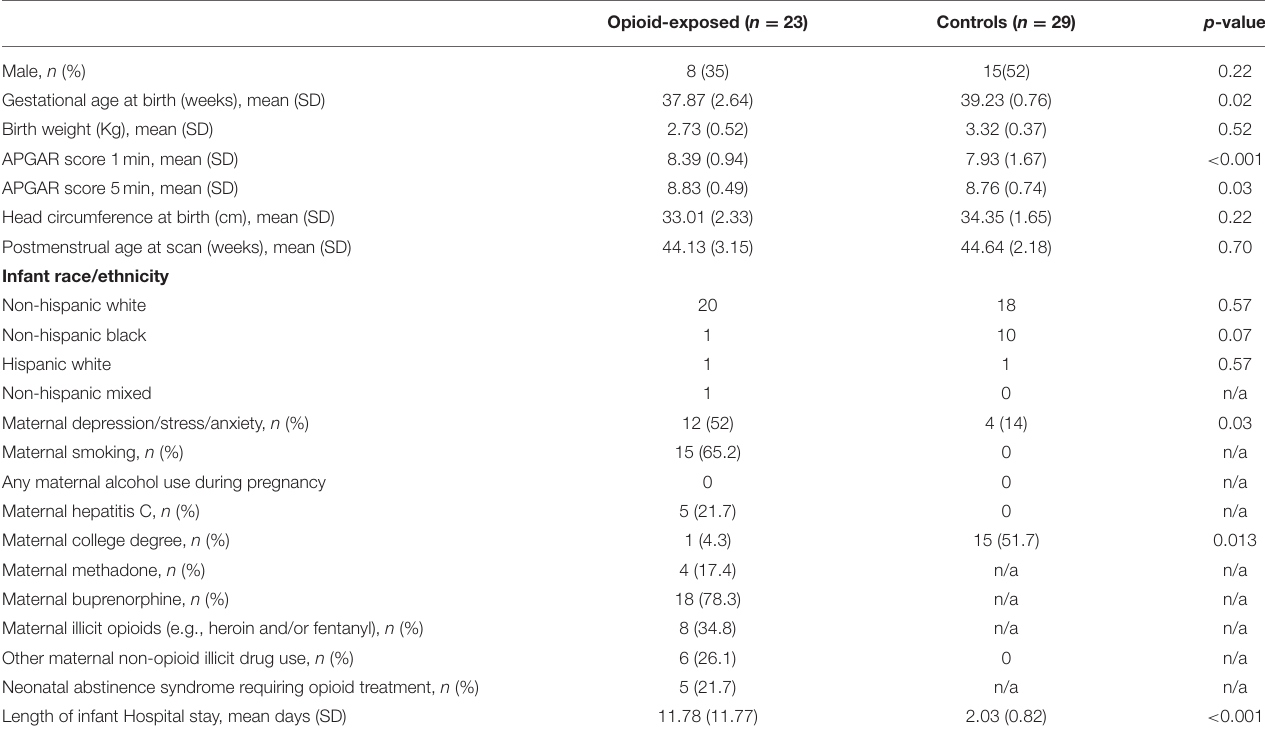
TABLE 1 | Demographics of study